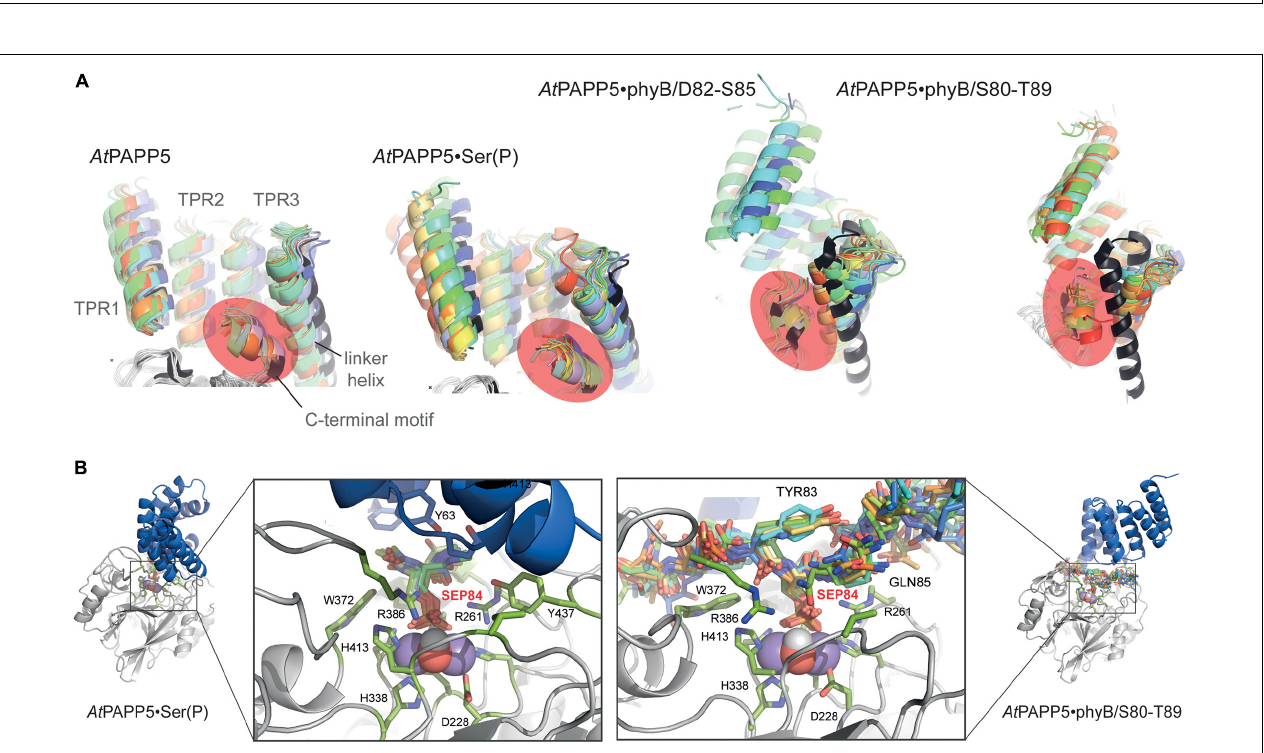
FIGURE 8 | Effect of phosphopeptide binding to the TPR-PP2A domain arrangement in At PAPP5. (A) The TPR regions of 10 MD snapshots (colored) are shown in comparison to the crystal structure of At PAPP5 (black). The C-terminal inhibitory motif is highlighted in orange. In the phyB peptide complexes the motif moves closer to the N-terminal portion of the linker helix. (B) Active site shown for 10 MD snapshots of the At PAPP5 • N-acetyl-SEP-NMe (left) and the At PAPP5 • phyB/S80-T89 complexes.